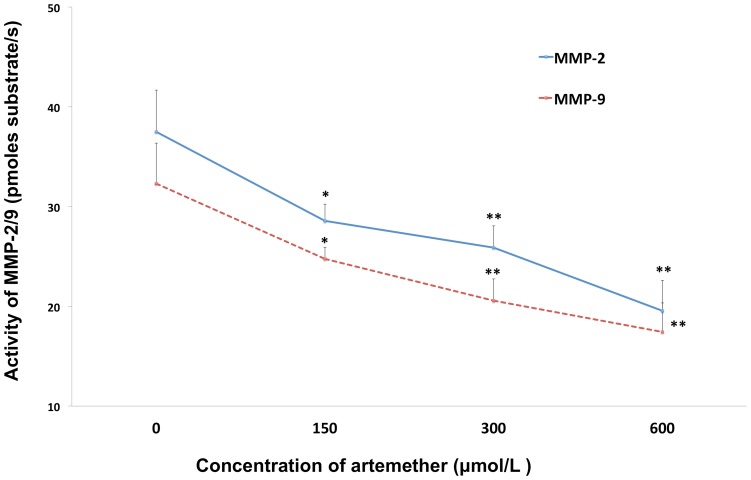
The effects of artemether on the enzymatic activity of MMP-2/9.Enzymatic activity of MMP-2/9 under the treatments of artemether (0, 150, 300, 600 µmol/L) was investigated by fluorescently quenched gelatin assay. The activity of the MMPs was expressed as picomoles substrate/s. The activity of both MMPs was inhibited significantly by artemether from the concentration of 150 µmol/L. *P<0.05; **P<0.01 (compared with control group). n = 4.